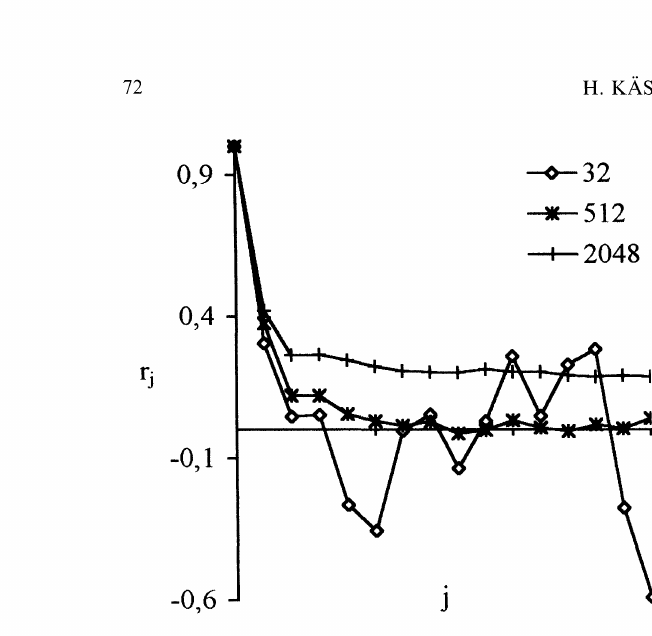
FIGURE 7 Dependence of the autocorrelation function of the size of the data set: The larger the extract of the consid- ered data used for the computation of the autocorrelation function the more evident becomes the influence of the non- stationarity present in the registration. The autocorrelation function with larger excerpt seems damped and shifted to lar- ger autocorrelation coefficients. Only for./’= the autocorrela- tion seems quite resistent against the trend contaminated